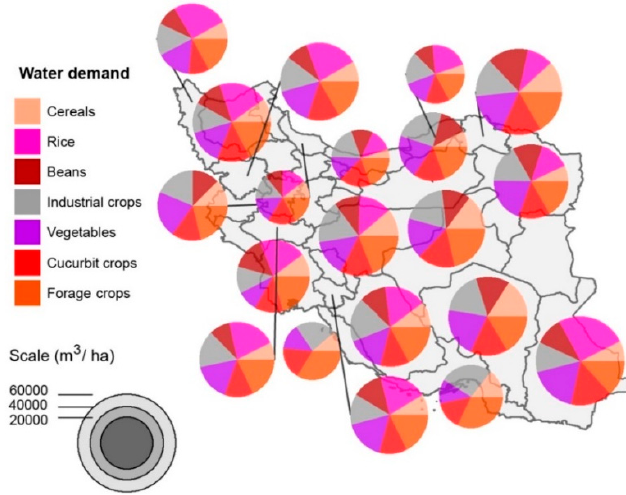
Figure 4. Average province-level crop water demand for the seven crop categories in 2015.